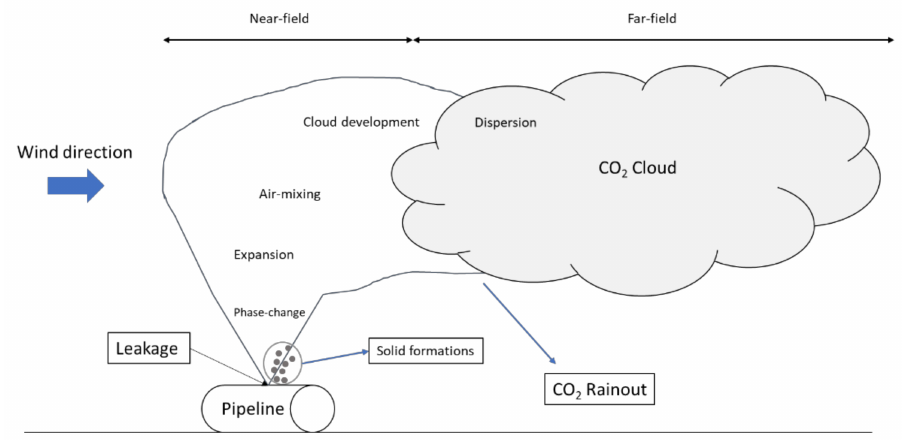
Figure 1. Schematization of a CO 2 release from an onshore pipeline.